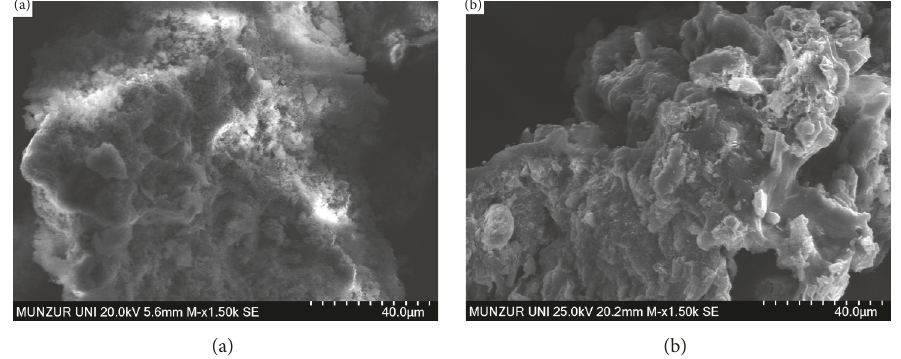
Figure 2: SEM pictures of the poly(AN-co-VP)/zeolite composite (a) before adsorption and (b) after adsorption.